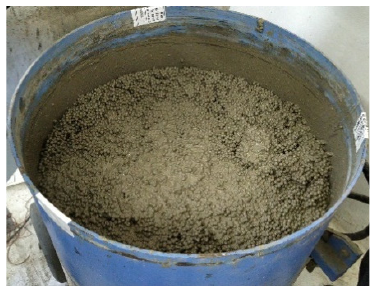
Figure 3. CFA-based LW mix.